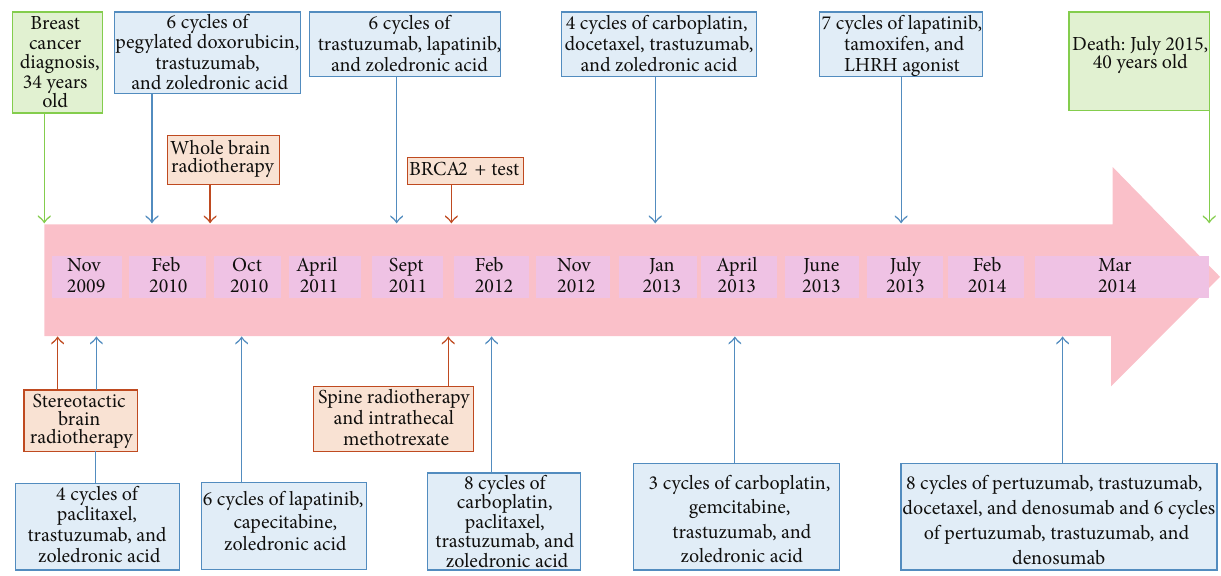
Figure 1: Timeline of patient’s diagnosis and